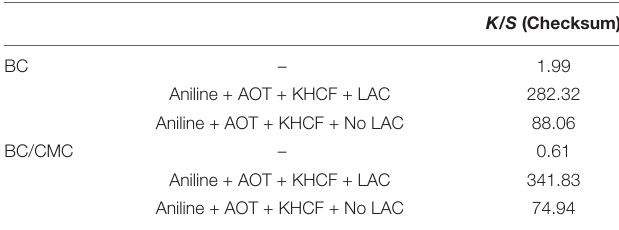
TABLE 5 | Color evaluation of BC and BC/CMC samples after aniline oxidation by laccase.